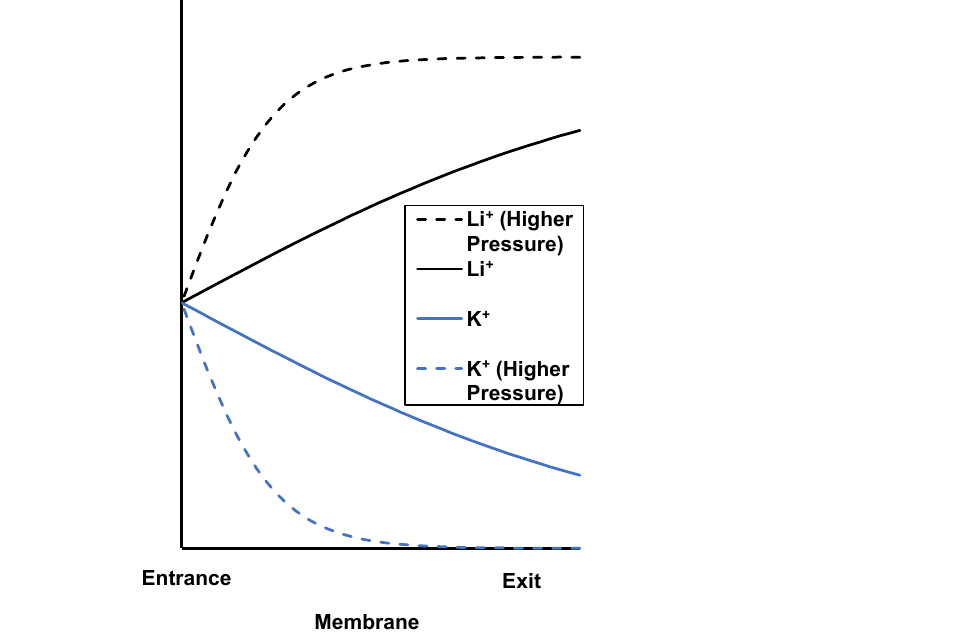
Figure 11. Qualitative K + and Li + concentration profiles within a nanopore. Dashed lines are profiles at a higher transmembrane pressure.